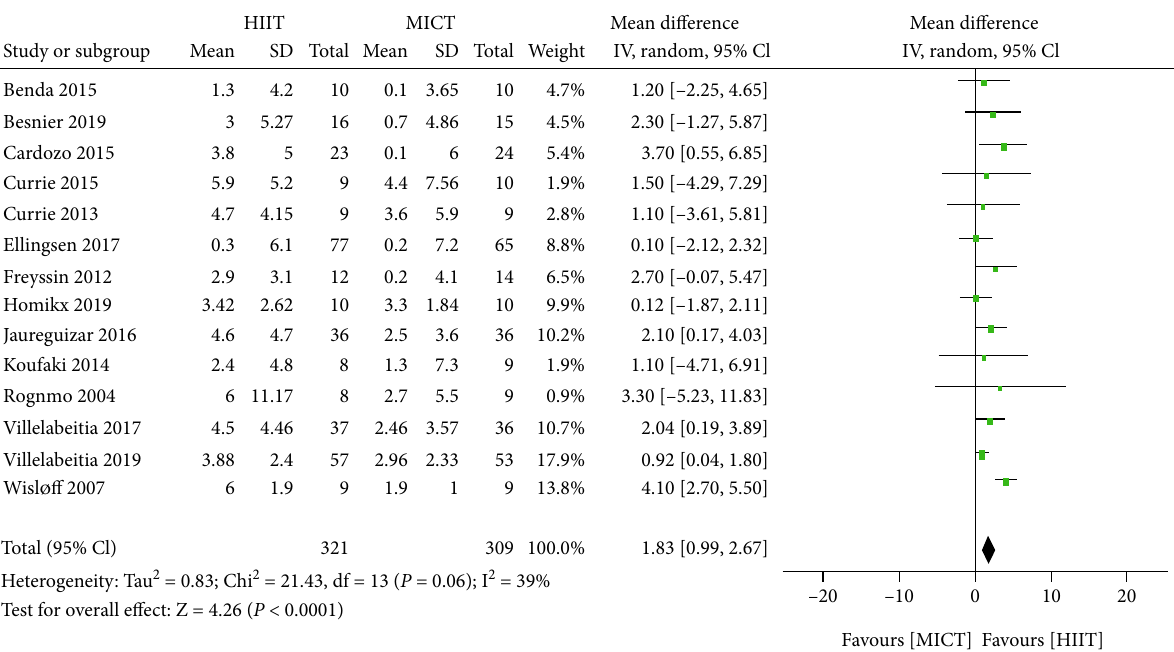
Figure 3: Forest plots of the e ff ect of HIIT and MICT on peak VO MICT: moderate-intensity continuous training; peak VO standard deviation; CI: con fi dence